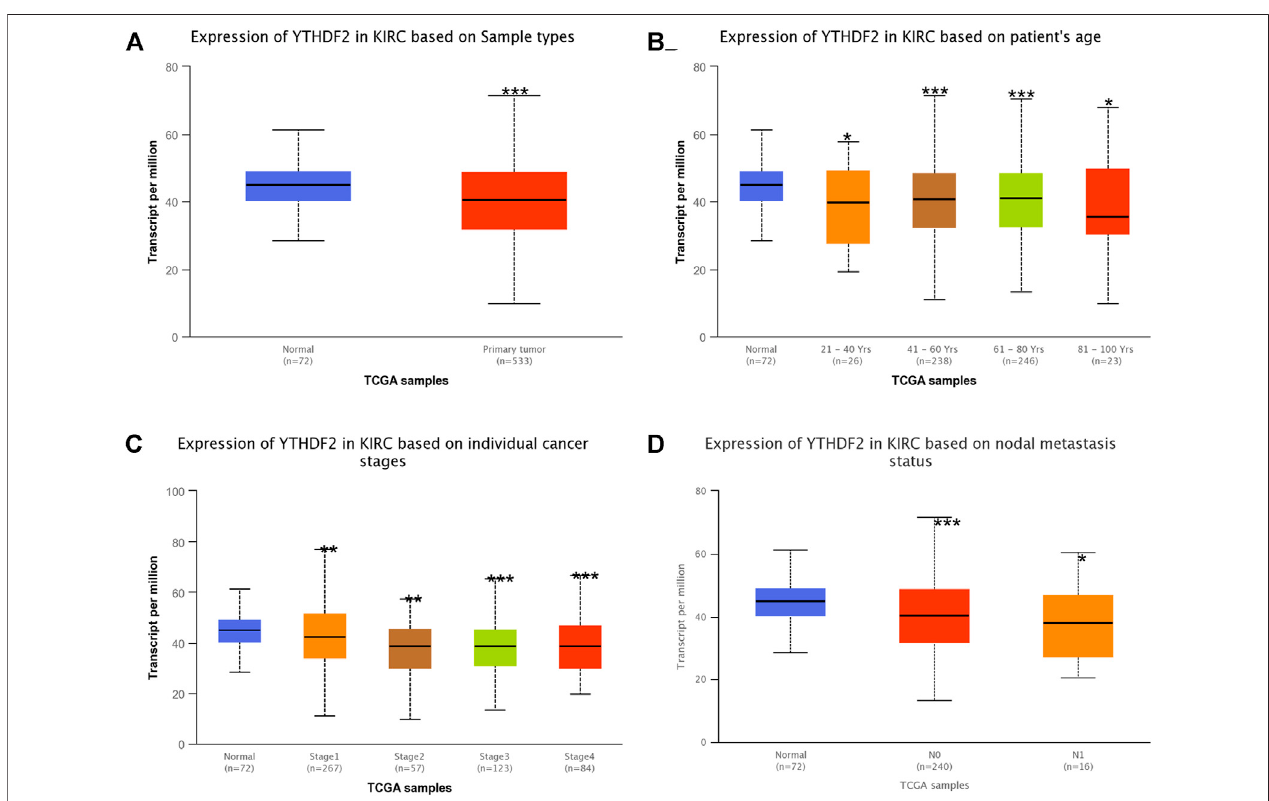
FIGURE2| TheexpressionofYTHDF2mRNAinsubgroupsofKIRCpatients(UALCAN). (A) ThecomparativeexpressionofYTHDF2innormalandKIRCsamples. (B) YTHDF2 expression in KIRC patients aged 21 – 40, 41 – 60, 61 – 80, or 81 – 100. (C) Comparative expression of YTHDF2 in normal and KIRC (Stage 1, 2, 3, or 4) samples. (D) Expression of YTHDF2 in normal and KIRC (with or without nodal metastasis) samples. *, p < 0.05; **, p < 0.01; ***, p < 0.001. KIRC, Kidney renal clear cell carcinoma.